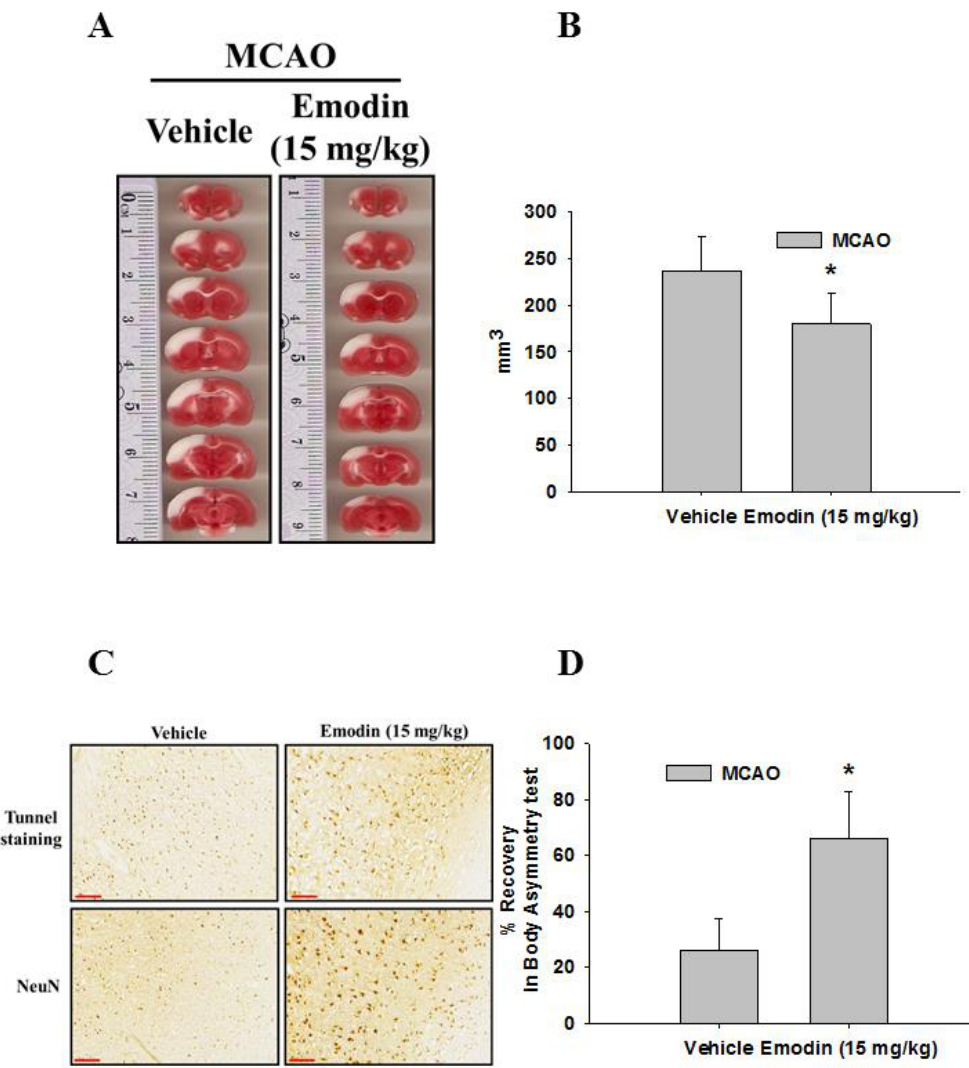
Figure 3. Emodin attenuates infarction sizes after middle cerebral artery occlusion (MCAO) in rats and improves the recovery in body asymmetry. ( A ) Brain sections were stained with 2,3,5-triphenyl- tetrazolium chloride (TTC) and ( B ) total volume of the infarction (the vehicle and emodin groups, n = 6 in each group. ( C ) Terminal Deoxynucleotidyl Transferase dUTP Nick End Labeling (TUNEL) and NeuN staining were observed in brain slices following ischemia / reperfusion injury. Scale bar = 100 µ m ( D ) Body asymmetry was tested after MCAO surgery. Data represent SEMs of three independent experiments. * p < 0.05 using Student’s t -test.